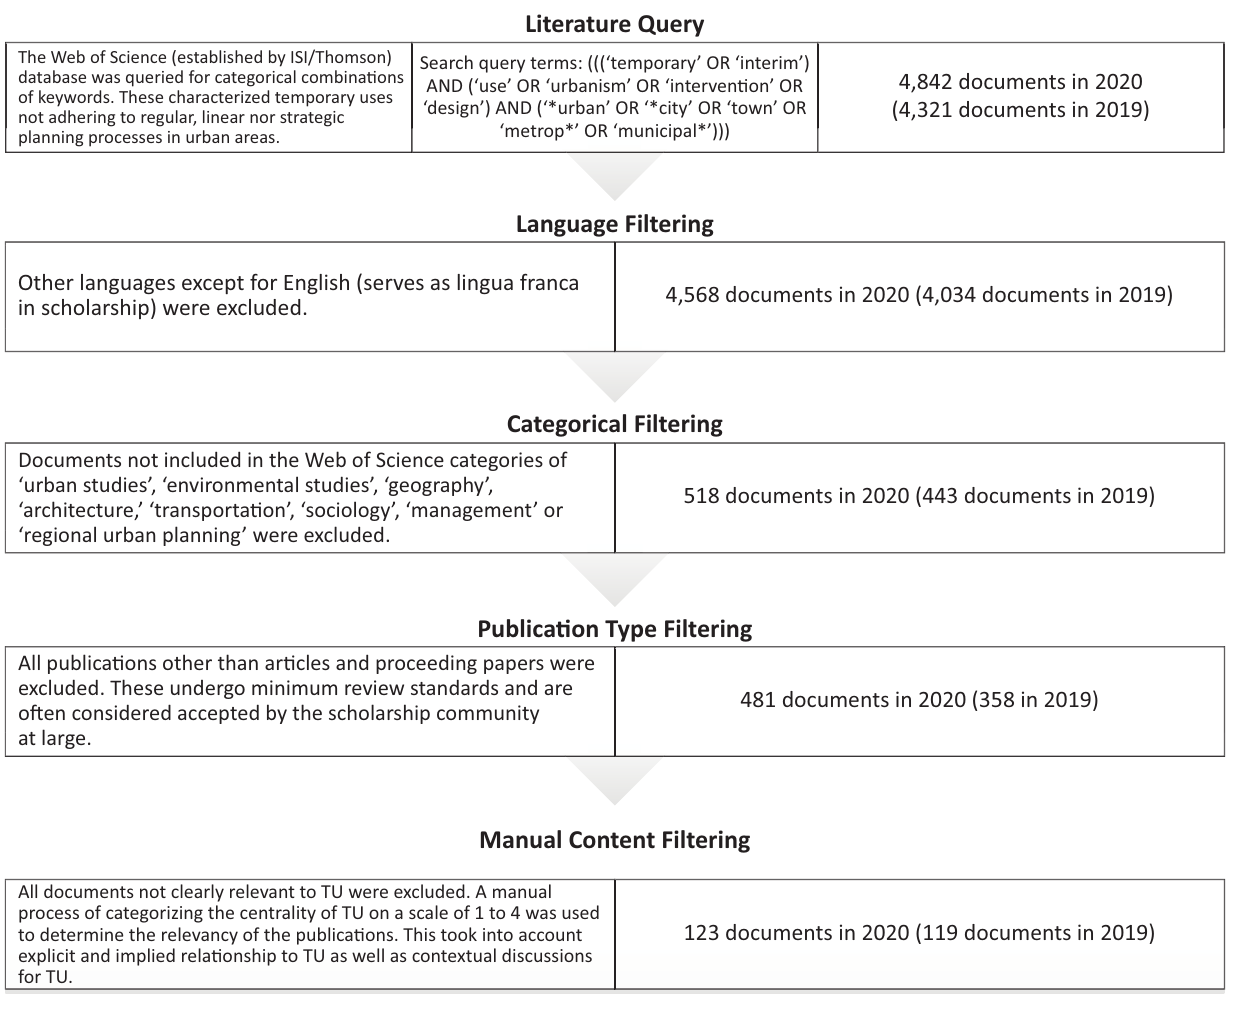
Figure 5. Breakdown of the stepwise approach to the literature search and filtering